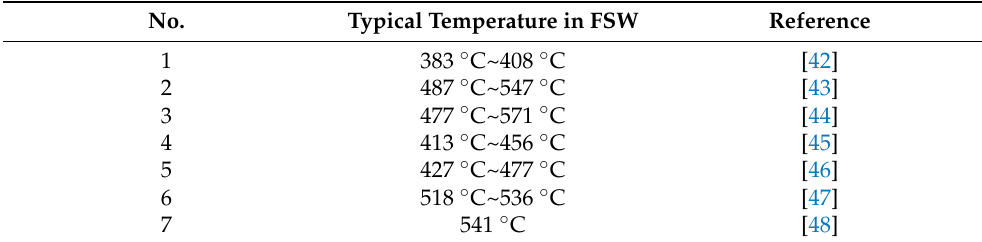
Table 2. Typical in-process temperature during friction stir welding (FSW) of AA6061.